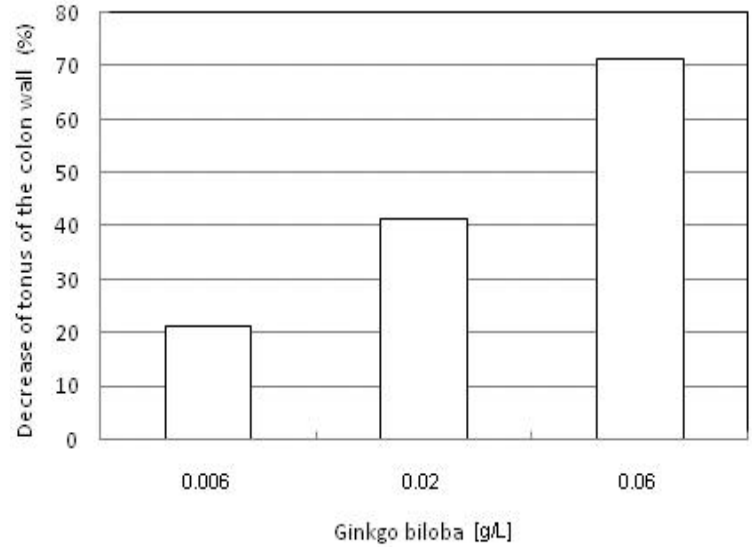
Figure 3. Dosage-dependent decrease of tonus of the colon wall in the presence of GBE.